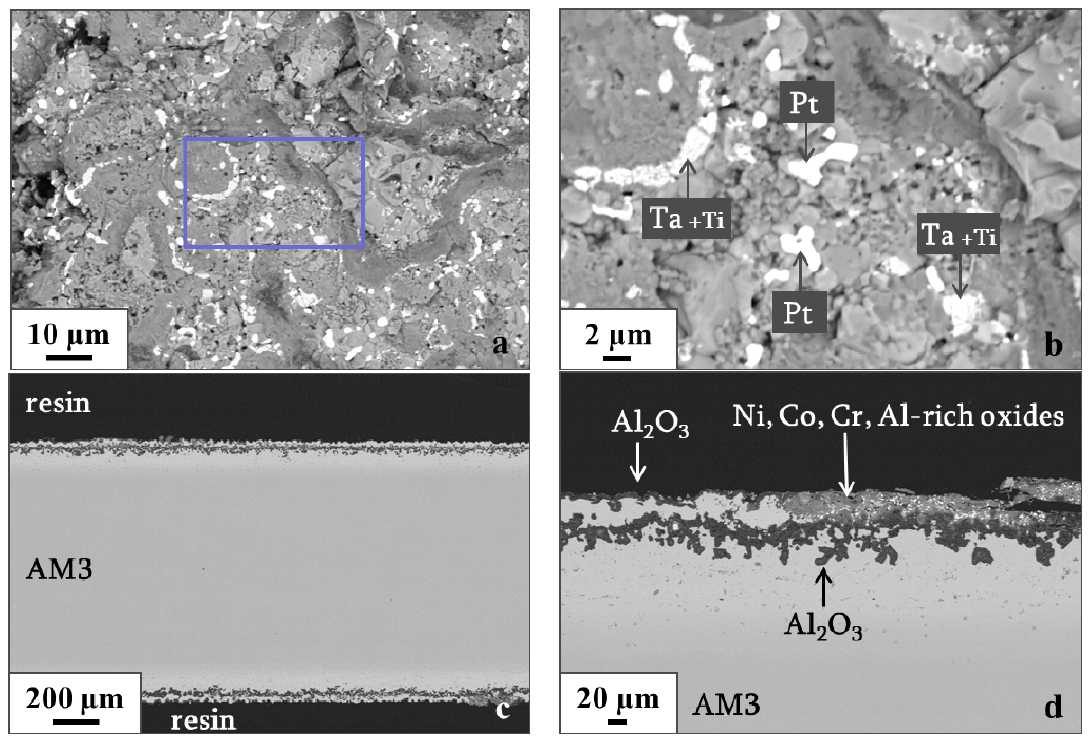
Figure 6. Area of catastrophic degradation of AM3-Trib-Pt/2 TBC system, after 300 cycles; ( a , b ) Surface morphology of the bond-coating, ( b ) is an enlargement of the rectangle area of ( a ) showing Ta-rich particles (containing some Ti) and Pt-particles; ( c , d ) Cross-sections ( c ) showing the extent of the catastrophic degradation and ( d ) giving details on the degraded area exhibiting external (Ni, Co, Cr, Al)-rich oxides and internal alumina. Thermal cycles of 1 h at 1100 °C, with a high-flow air cooling. SEM images in BSE mode.